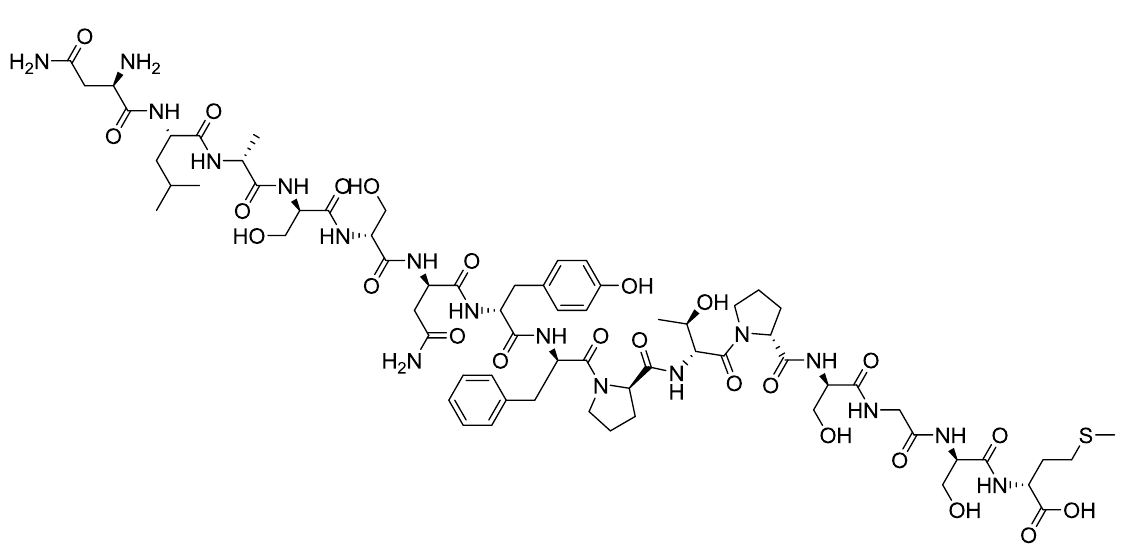
Figure 10. Structure of Human papillomavirus